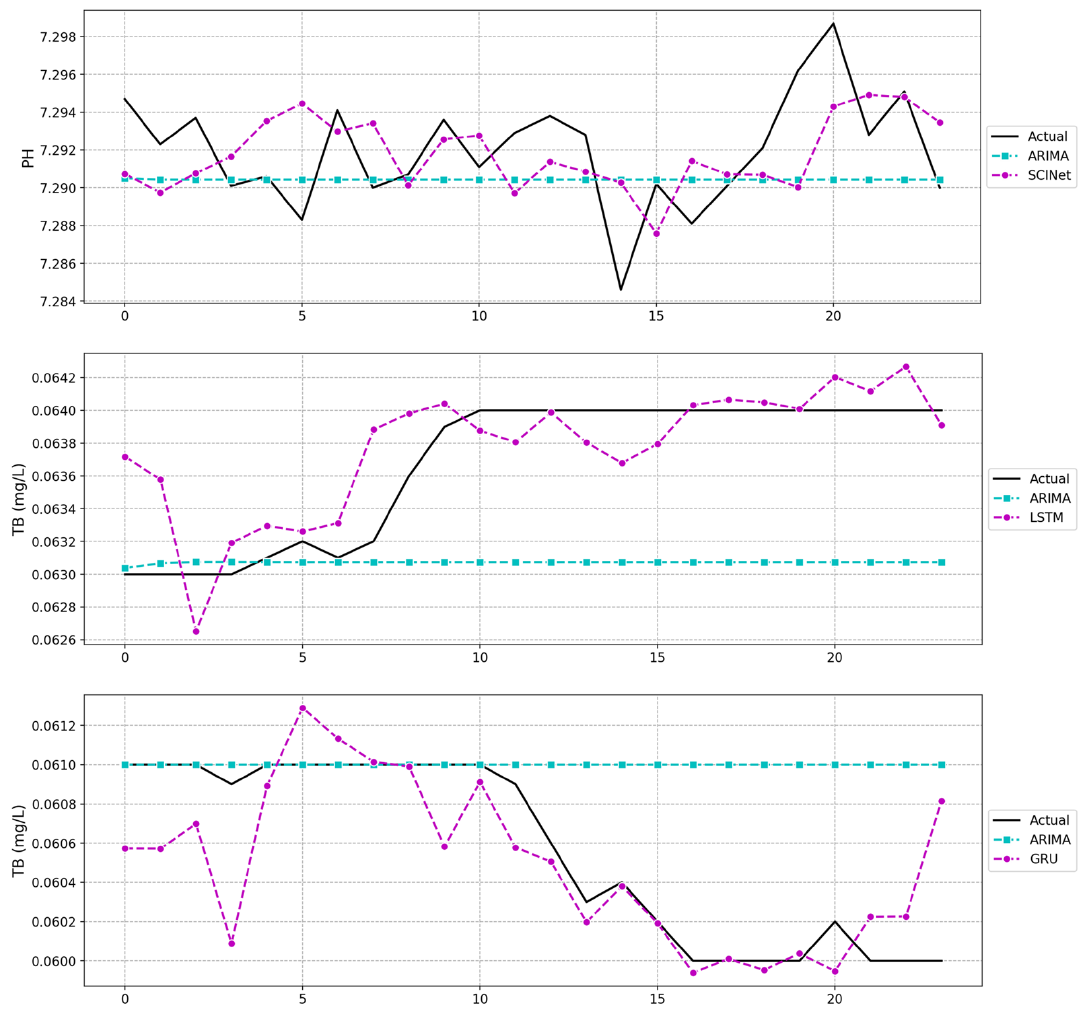
Figure 16. Comparison of actual and predicted water quality values for ARIMA and deep learning models over a 24-hour period.